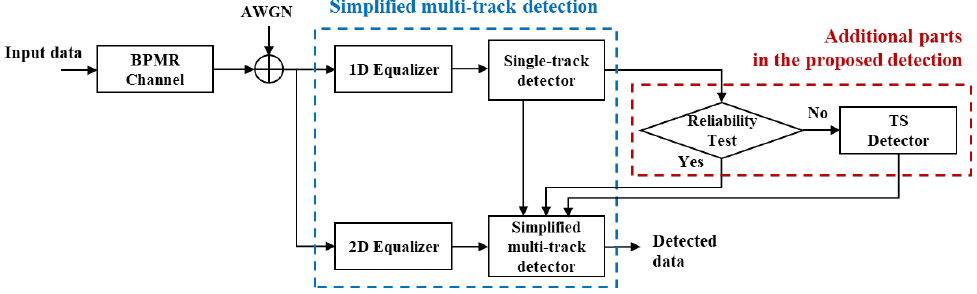
Figure 1. Block diagram of the proposed detection scheme.